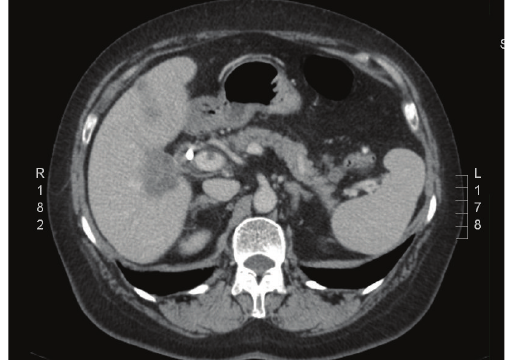
Figure 6: Partial response of the enormous mass in the right liver